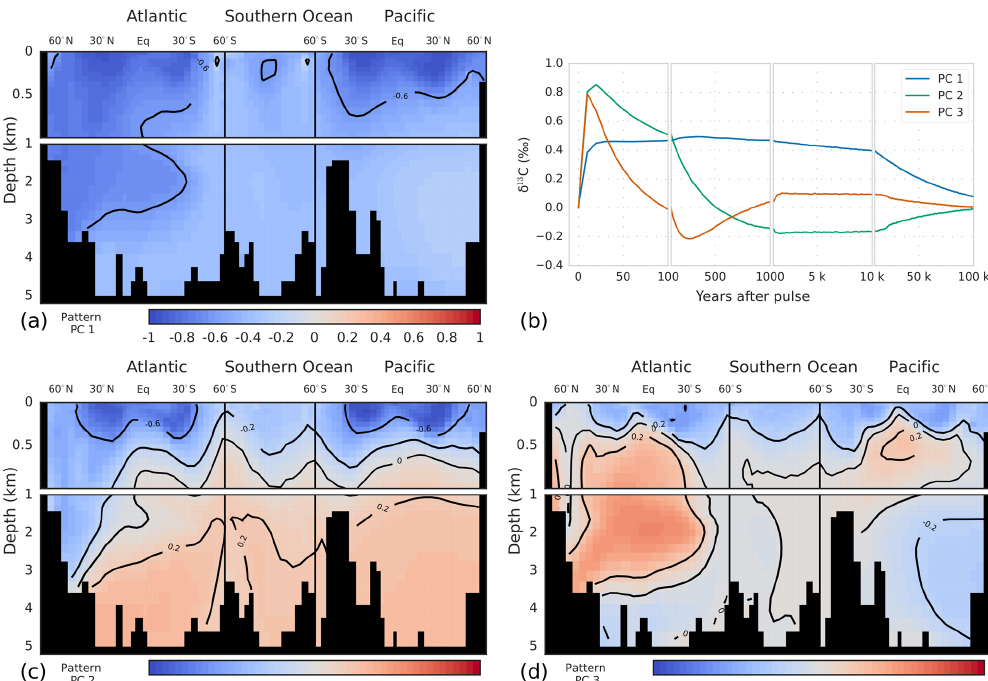
Figure 7. EOF pattern of the (a) first, (c) second, and (d) third principal components used to represent the spatial perturbation in (cid:49)δ 13 C of dissolved inorganic carbon in the ocean. Corresponding PC time series are shown in (b)